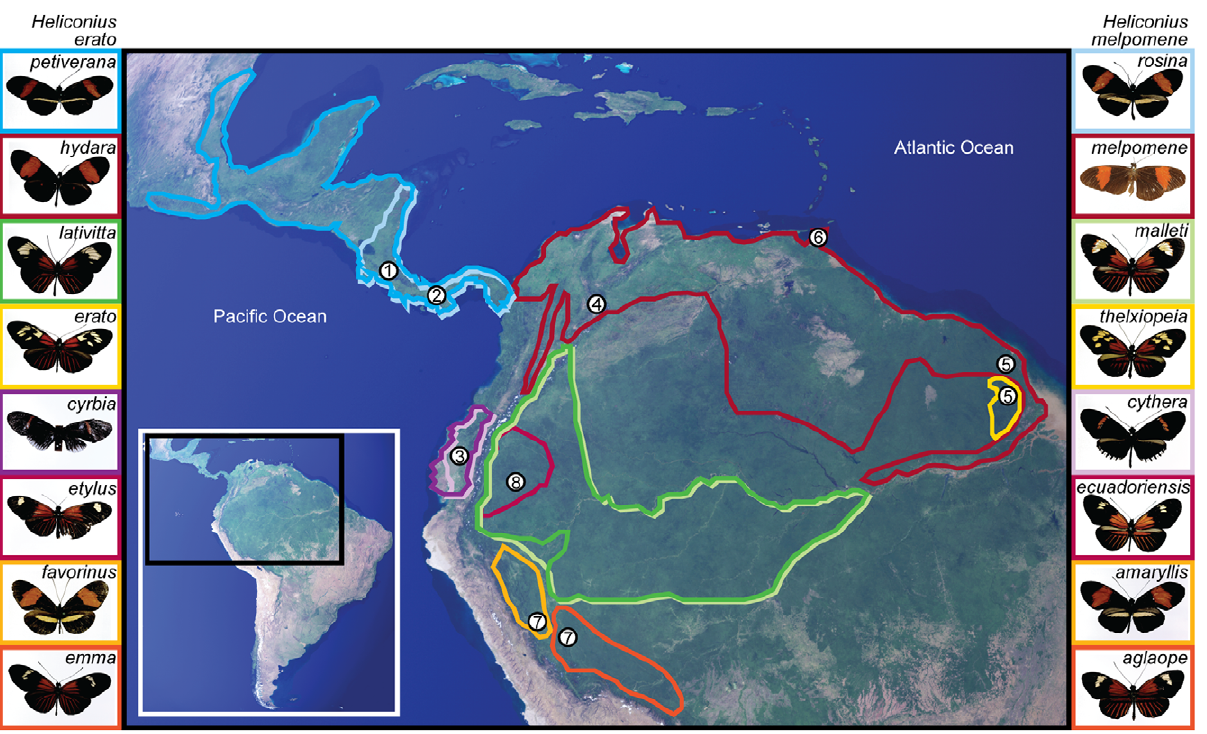
Figure 1. Wing patterns morphs and geographic distributions of the Mu¨llerian co-mimics H.erato and H.melpomene . Mimetic morphs [3,15,30] (aligned rows), from H. erato (left) and H. melpomene (right), included in this study (photographs show the type specimens). Coloured boundaries on a satellite image of Central and South America indicate the geographic range of each morph [3]. Numbers indicate countries where morphs were sampled (by [29,30]), West of the Andes: 1 Costa Rica, 2 Panama, 3 West Ecuador; East of the Andes: 4 Colombia, 5 French Guiana, 6 Trinidad, 7 Peru and 8 East Ecuador.